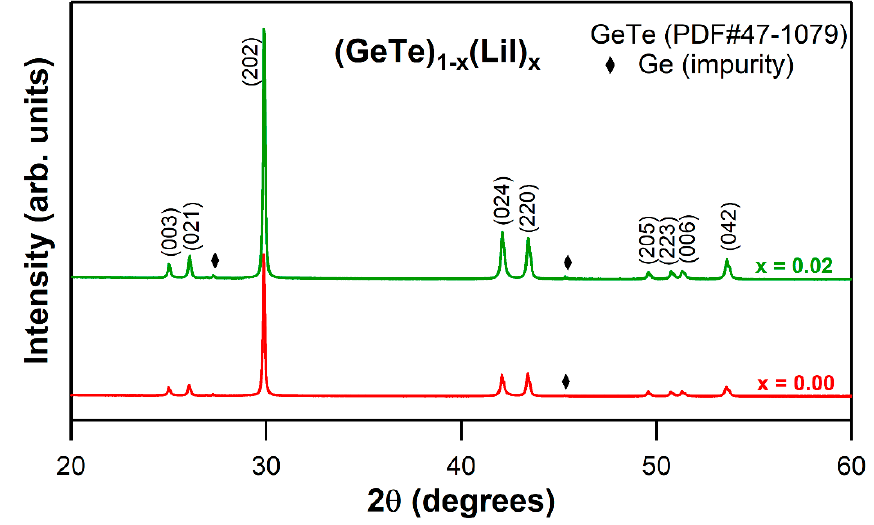
Figure 1. XRD patterns for (GeTe) 1-x (LiI) x ( x = 0–0.02) samples.